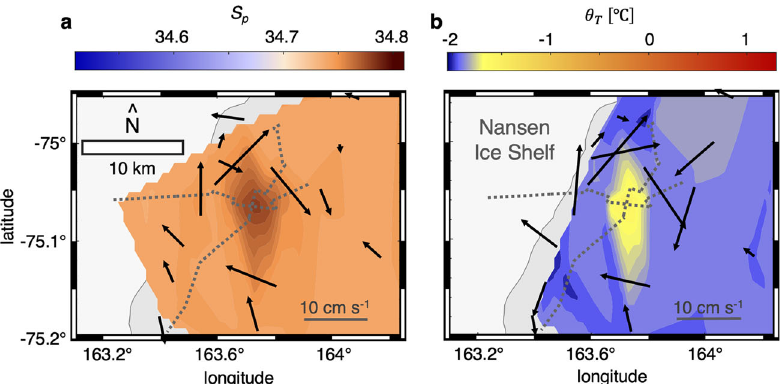
Fig. 4 Eddy horizontal cross sections. a Practical salinity and current velocity at 300 m depth. b Potential temperature and current velocity at 130 m depth. Light grey polygons show the ice shelf extent. Dashed grey lines indicate glider transects parallel and perpendicular to the NIS calving front, which intersect at the center of the eddy ( r = 0). The data have been adjusted spatially to offset the northeastward advection of the eddy (see Methods). The grey background signi fi es regions of no data. Additional maps of surface salinity, surface temperature, salinity at 130 m, and salinity at 300 m are provided in Supplementary Fig. S3.